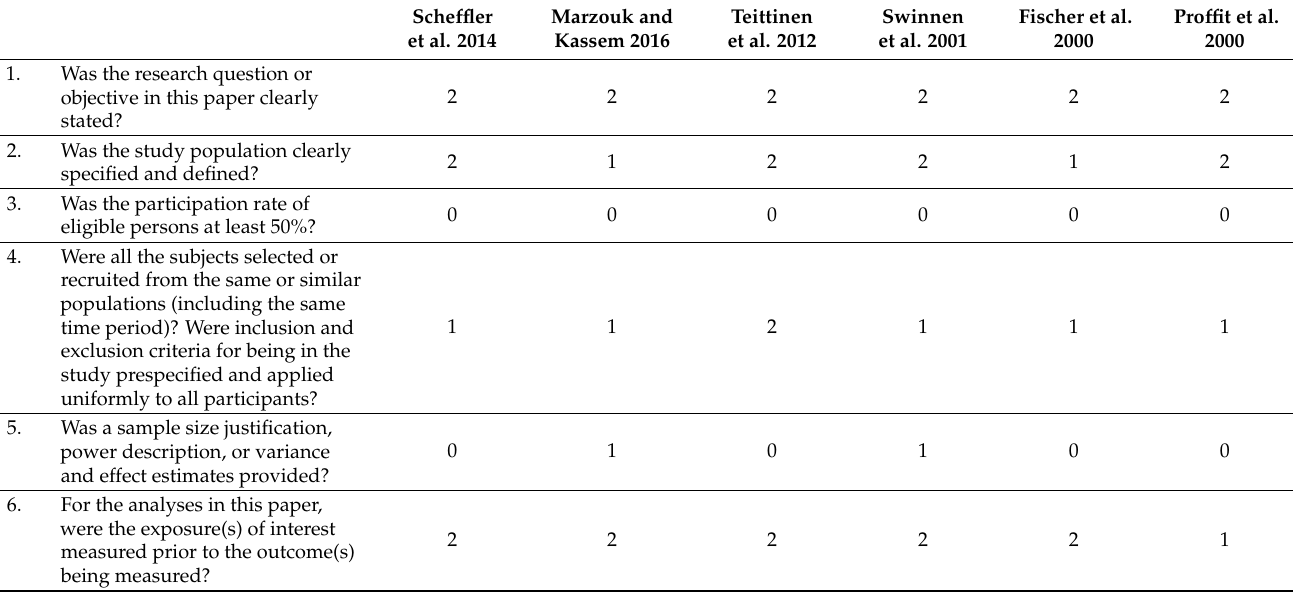
Table 3. Assessment of the risk of bias in the included articles by the National Institute of Health (NIH) quality assessment tool for cohort